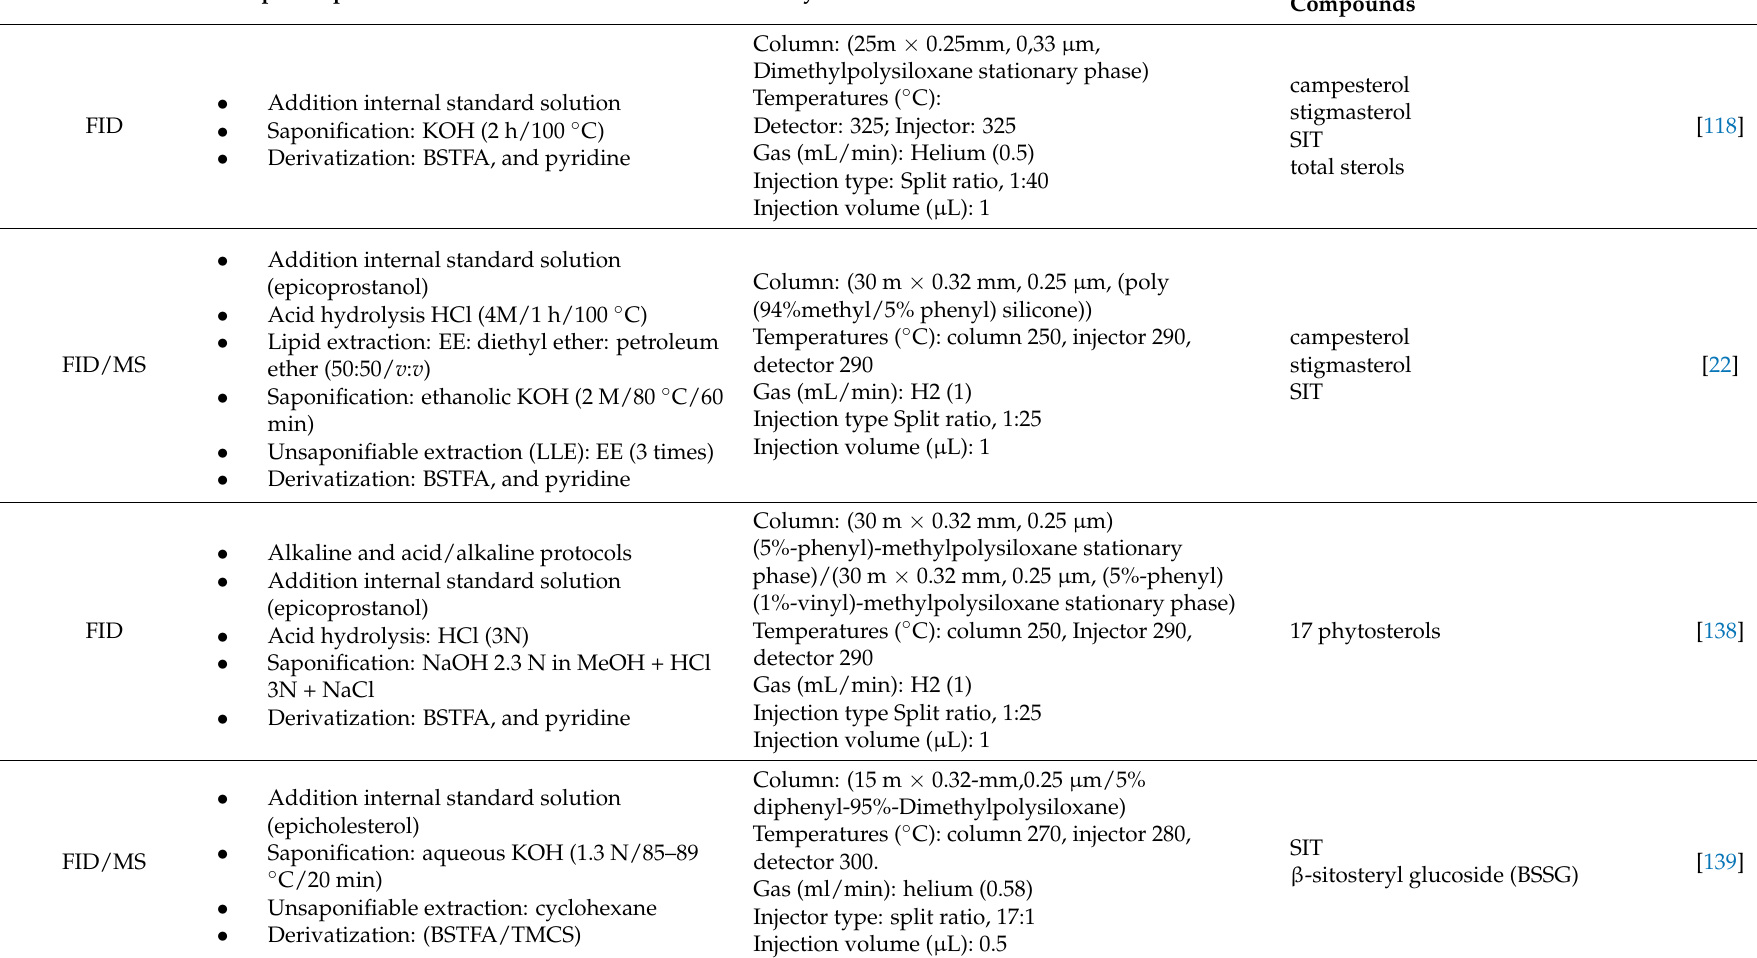
Table 4. Determination of total phytosterols in dietary supplements by chromatographic methods. Method